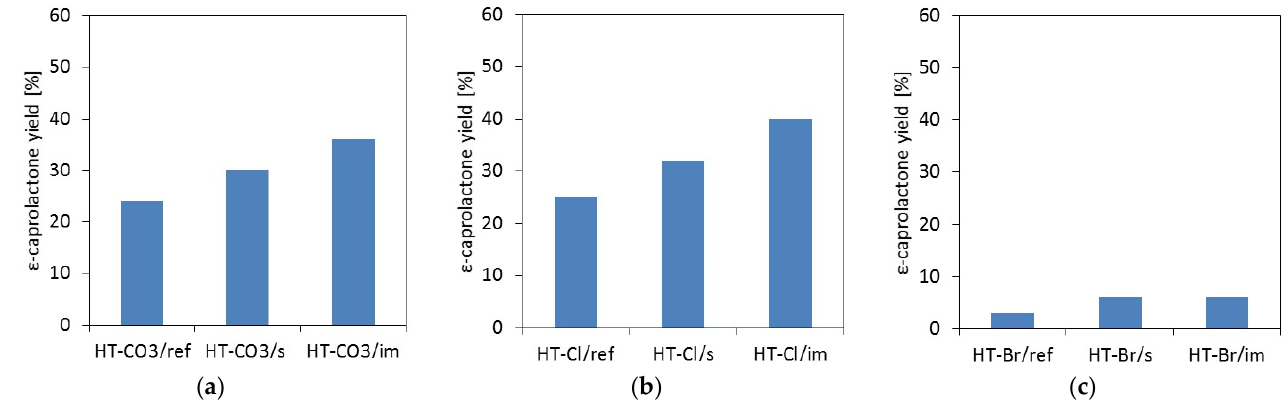
Figure 6. Yield of ε -caprolactone in HT materials: ( a ) carbonate forms; ( b ) chloride forms; ( c ) bromide forms.